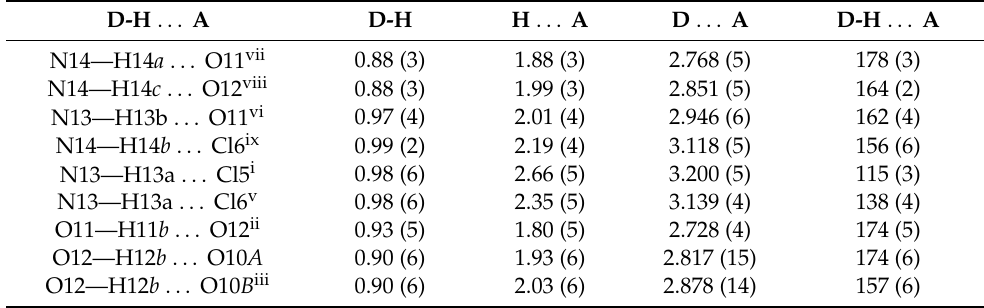
Table 4. H-bond characteristic (Å, º).